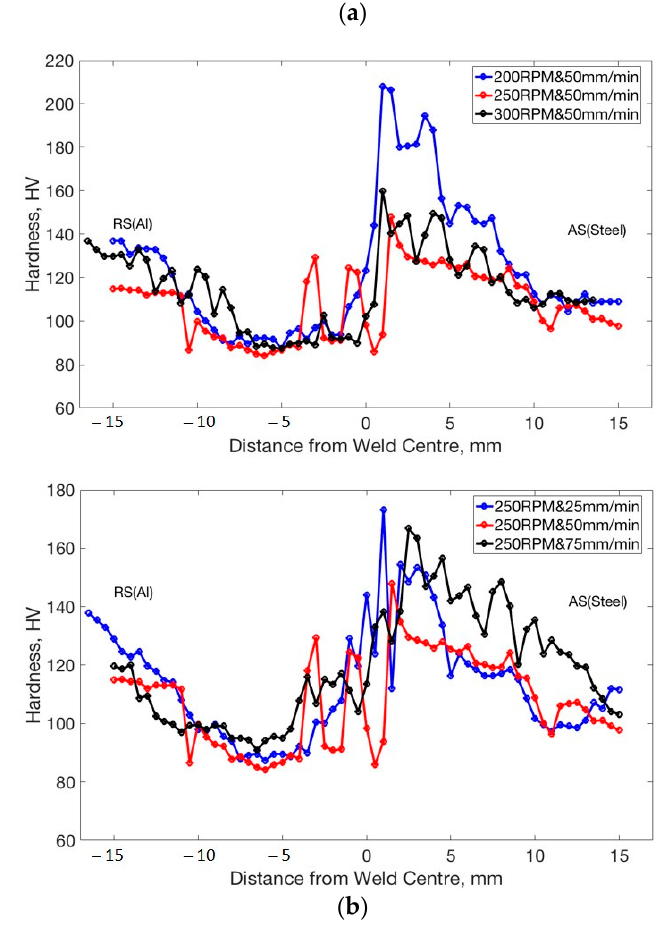
Figure 13. Hardness profiles across the joint interface along the transverse cross section of the joint at the middle in the thickness direction. ( a ) Constant welding speed and different rotation rates, ( b ) Constant rotation rate and different welding speeds.